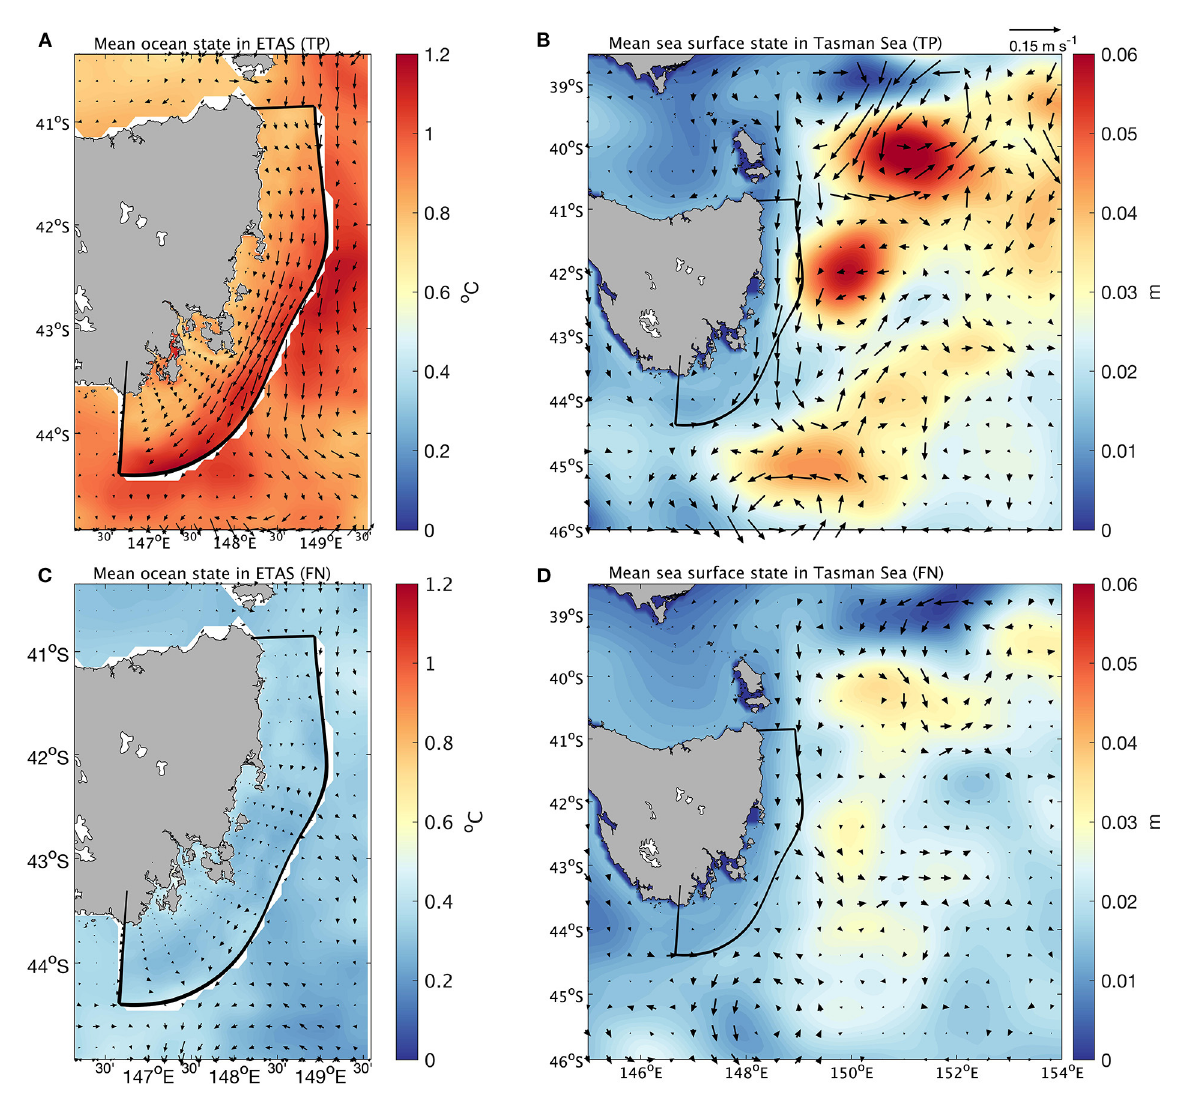
FIGURE13 Mean states off eastern Tasmania and in the southern Tasman Sea across true positive and false negative predictions collected from all six experiments. (A) The SSTA ( ◦ C) and horizontal current anomaly (m/s) off eastern Tasmania averaged across all true positive forecasts. (B) The SSHA (m) and horizontal current anomaly (m/s) in the southern Tasman Sea averaged across all true positive forecasts. (C) The SSTA ( ◦ C) and horizontal current anomaly (m/s) off eastern Tasmania averaged across all false negative forecasts. (D) The SSHA (m) and horizontal current anomaly (m/s) in the southern Tasman Sea averaged across all false negative